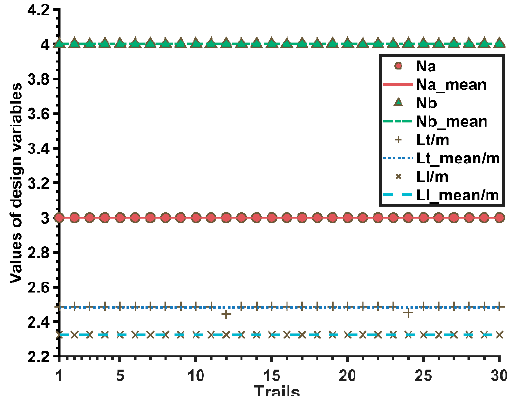
Figure 7. Variation of optimal decision variables and corresponding average values after running the program 30 times.